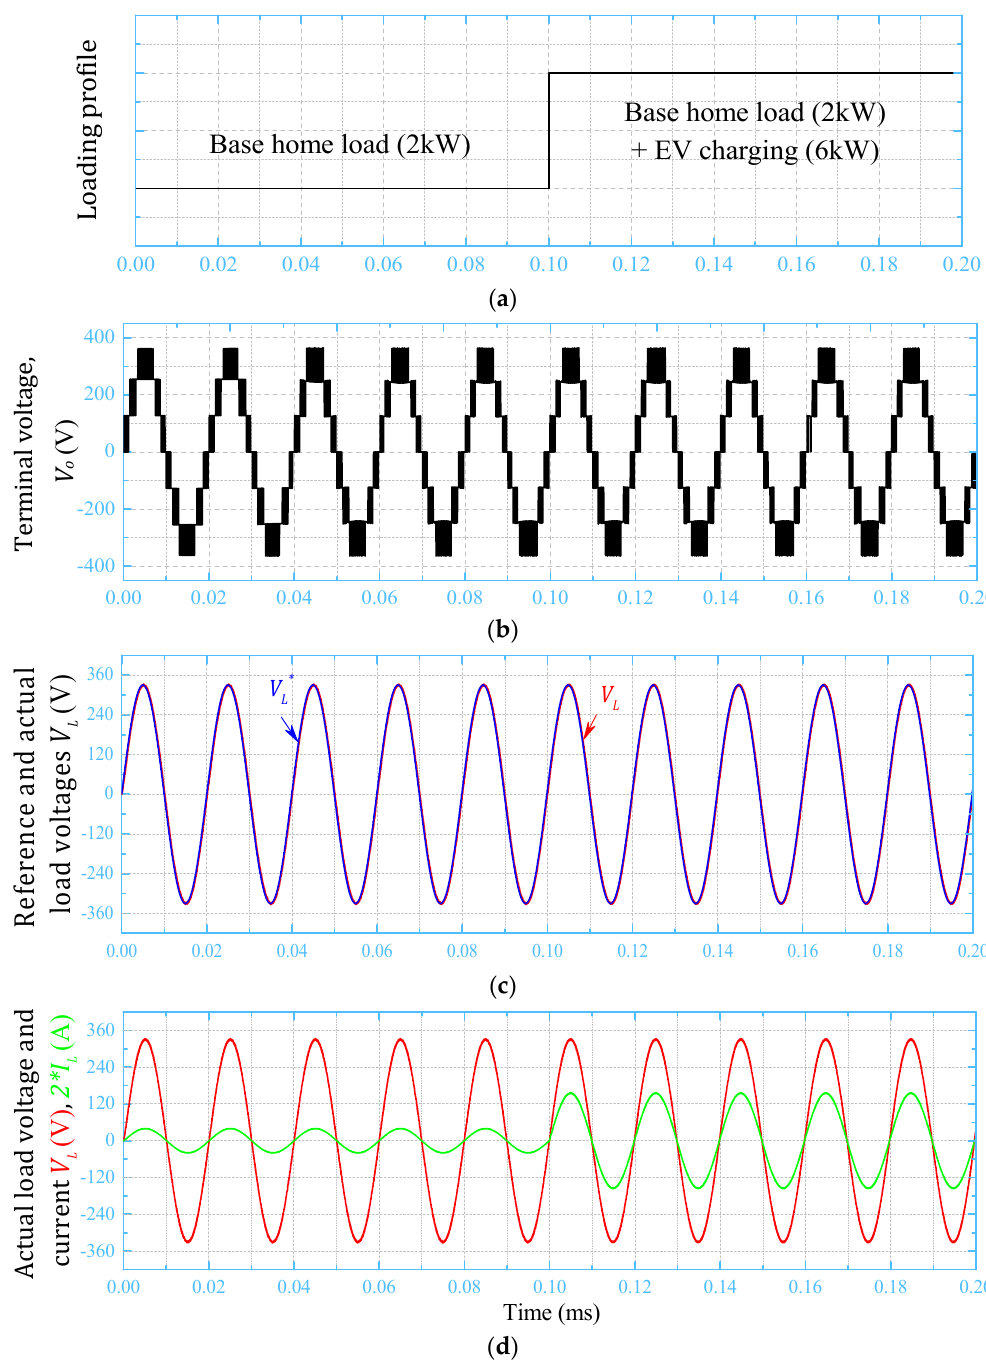
Figure 13. Simulation results of the proposed 7-level inverter for house loads voltage control (2 kW). ( a ) Load reference and actual voltages, ( b ) Load voltage and current.